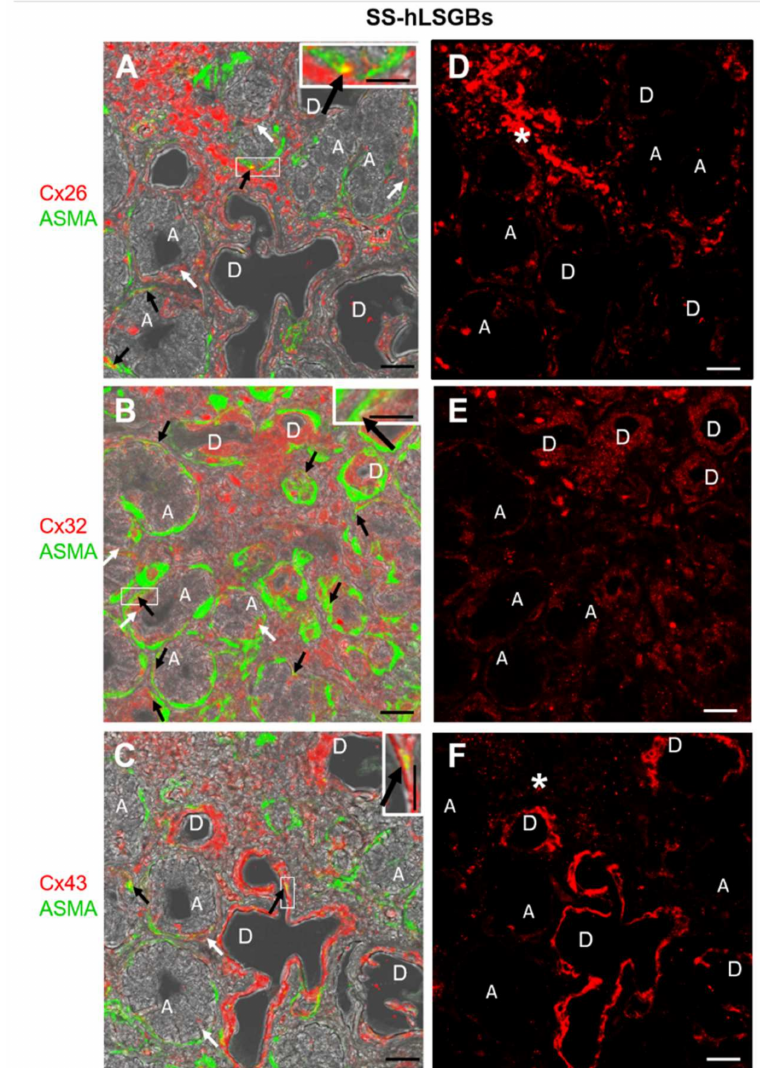
Figure 2. IF analysis for Cx26, Cx32, and Cx43 in SS-hLSGBs. ( A – C ) Representative confocal microscopy images of double IF with transmitted light contrast. Merged images show Cx positivity in red, ASMA positivity in green, and Cx-ASMA colocalization in yellow. These images have been modified by enhancing the saturation in order to better appreciate the yellow stain. White arrows indicate red immunoreaction at the plasma membrane of the duct cells and at the basal/basolateral side of the acinar cells. Black arrows point to the yellow spot due to the colocalization of Cx and ASMA. Inserts show the higher magnification of the squares. ( D – F ) Single IF images representing Cx immunoreactions (red) corresponding to ( A – C ) microscopic fields. Asterisks (*) point to the inflammatory cells. A, acinus; D, duct. Scale bars, 20 µ